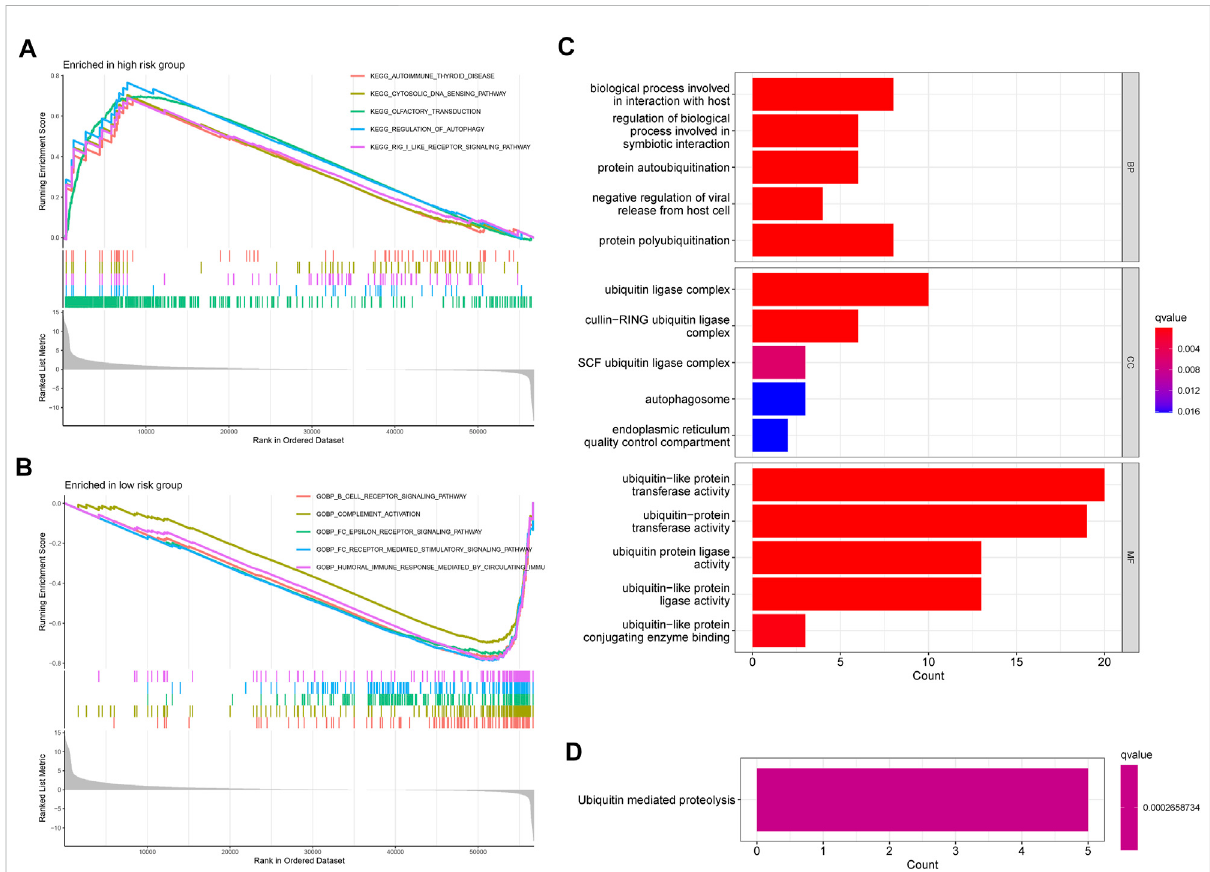
FIGURE 7 GSEA, GO, and KEGG. (A) The GSEA showed signi fi cant enrichment in the low-risk groups. (B) The GSEA showed signi fi cant enrichment in the low-risk groups. (C) The signi fi cant GO terms are based on the prognosis-related ubiquitin-related genes. (D) The signi fi cant KEGG pathways are based on the prognosis-related ubiquitin-related